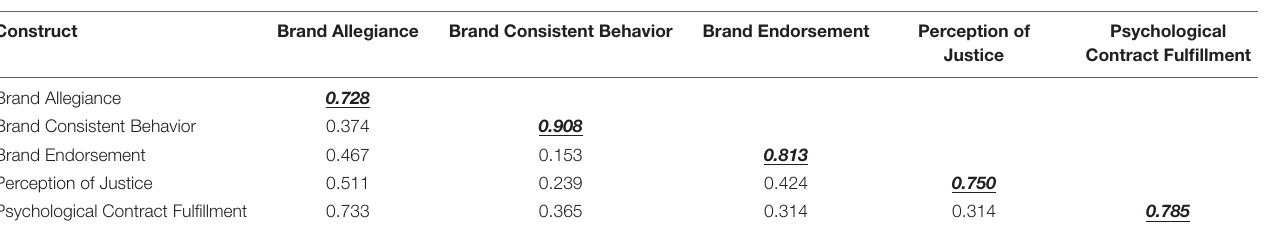
TABLE 3 | Discriminant validity (Fornell–Larker